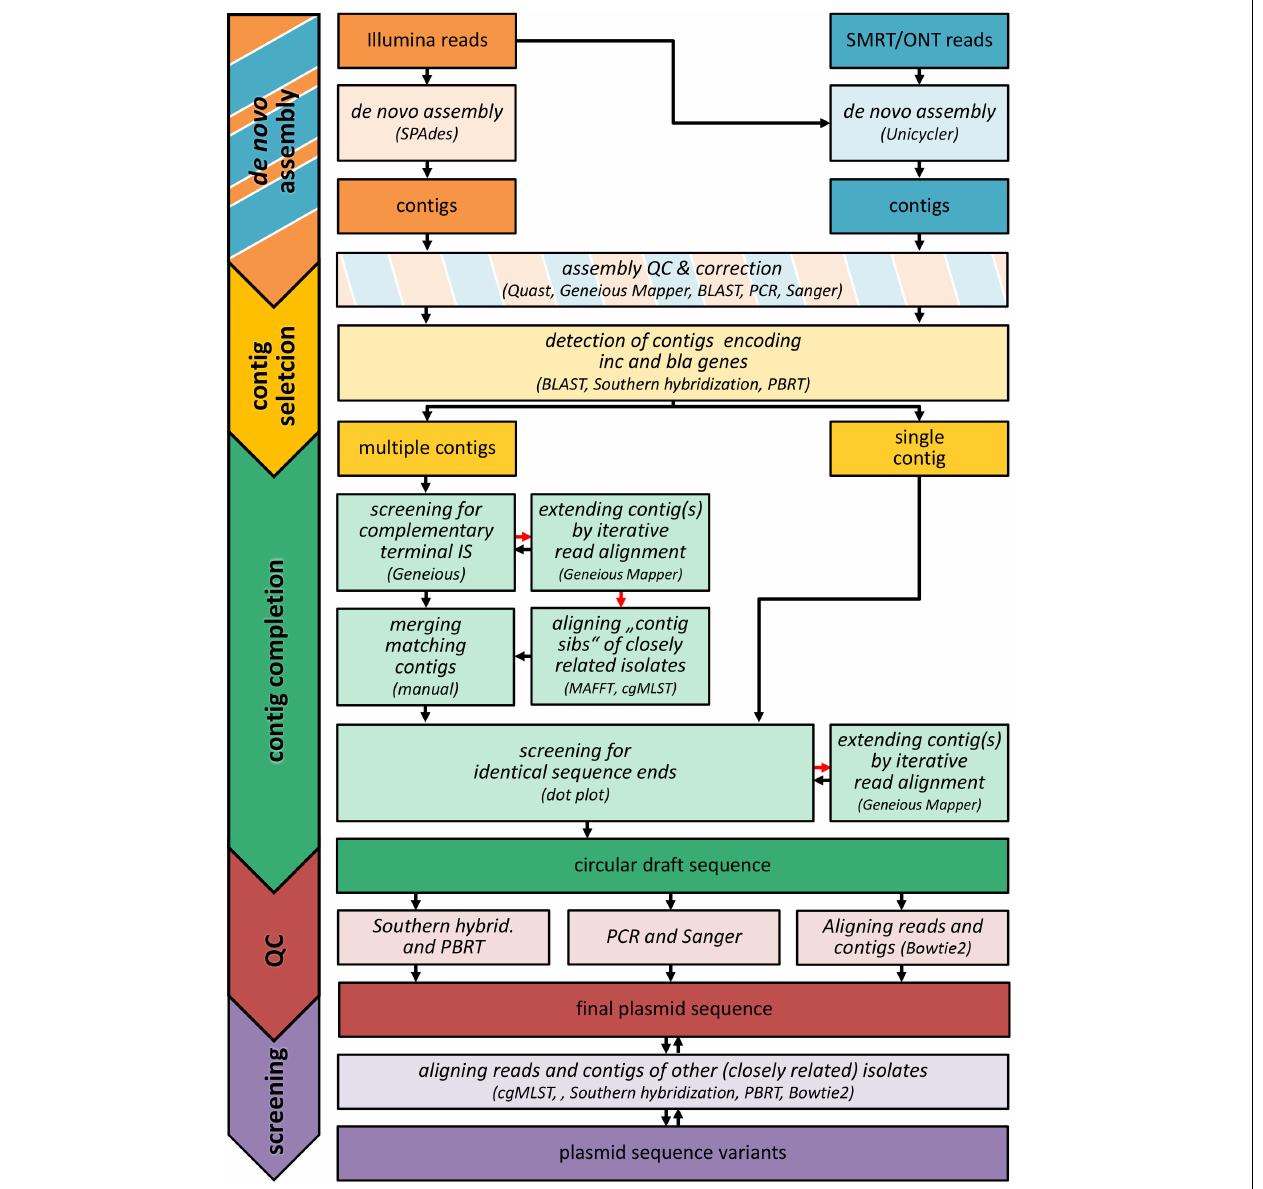
FIGURE 1 | Workflow of plasmid reconstruction. The graphic illustrates the different strategies used for the reconstruction of outbreak-related replicon sequences in this study. The different analyses tasks are shown in italics (bright colored boxes). The respective input and output (reads, contigs, draft and final sequences) is highlighted by boxes with strong colors. If a method could not successfully applied, alternative methods were used (indicated by red arrows). For a detailed description of the reconstruction process, see Supplementary Data Sheet 1 . SMRT: PacBio R (cid:13) Single Molecule Real Time (SMRT) sequencing; ONT, Oxford Nanopore Technology; Inc, replication sequences; bla , β -lactamase gene; IS, insertion sequence; QC, quality control; PBRT, PCR-based replication typing; contig sib(ling)s, orthologous contigs; cgMLST, core genome